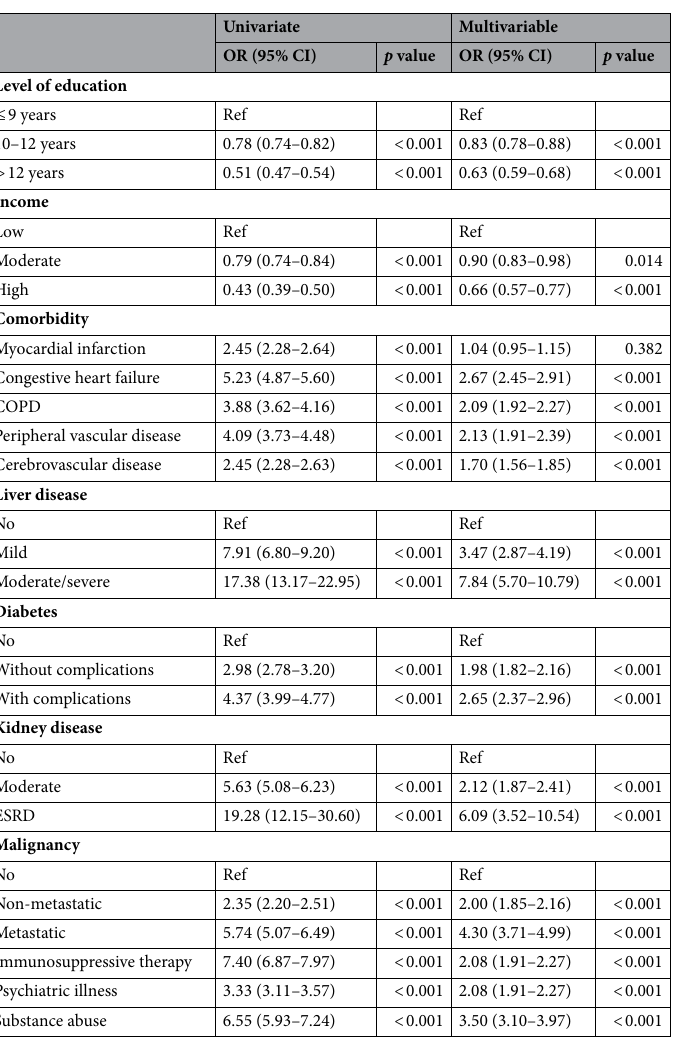
Table 3. Logistic regression analysis for the risk of community-acquired sepsis, all patients. OR Odds ratio, CI Confidence interval, COPD Chronic obstructive pulmonary disease, ESRD End-stage renal